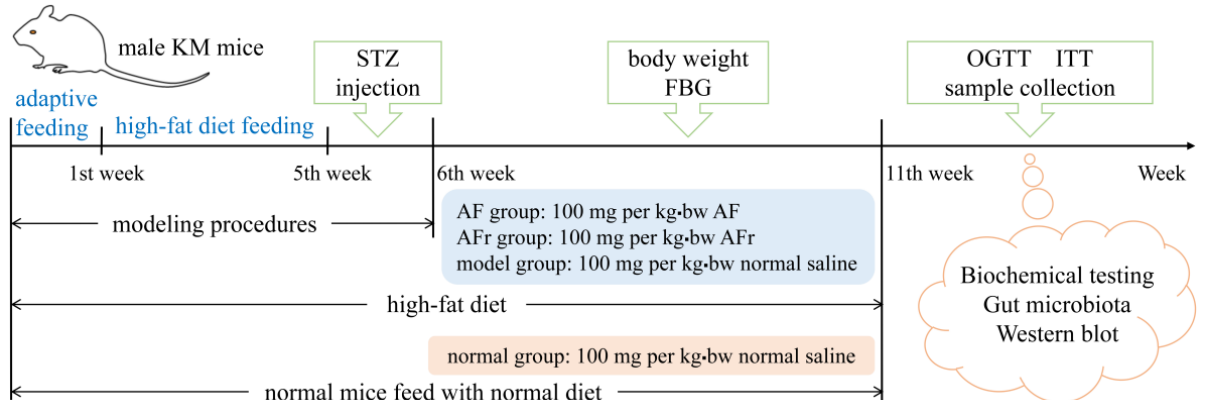
Figure 1. The schedule of animal experiment procedures. KM mice, Kunming mice; STZ, streptozotocin; FBG, fast blood glucose; OGTT, oral glucose tolerance test; ITT, insulin tolerance test. AF represents A. tenuissimum flower extract. AFr represents the mixture of ethyl acetate part and n -butanol part.